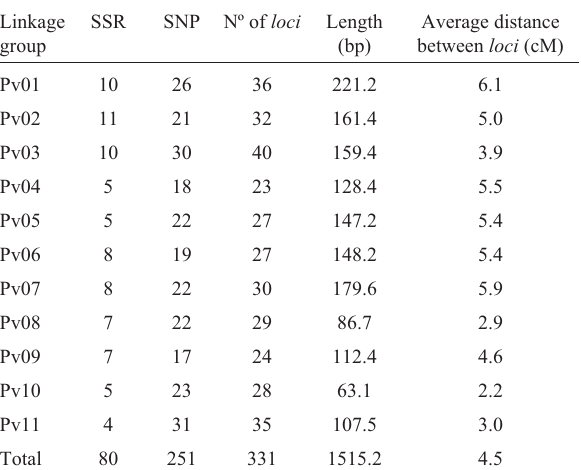
Table 1 - Distribution of SSRs and SNPs, number of loci , linkage group length and average distance between markers in the genetic map devel- opedfromtheAND277xSEA5(AS)populationusingOneMap ® software. Linkage group